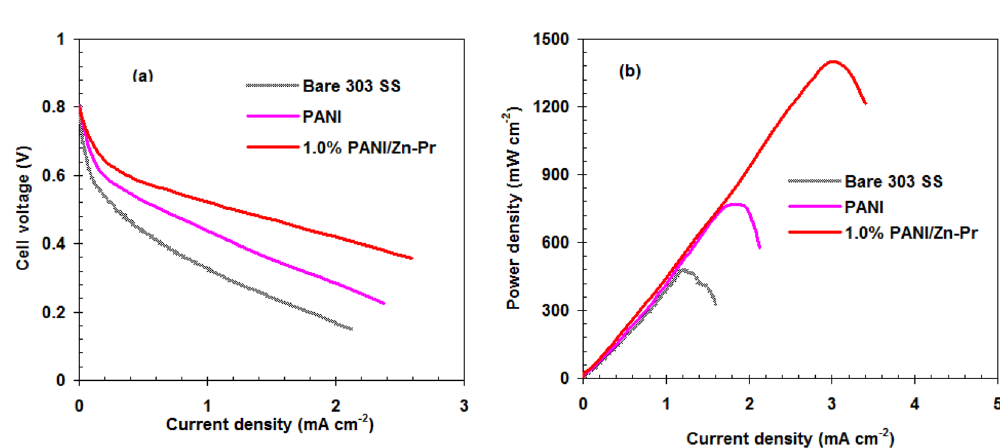
Figure 8. Output cell voltage ( a ) and power density ( b ) for single PEMFC cell using uncoated and coated 303 SS bipolar